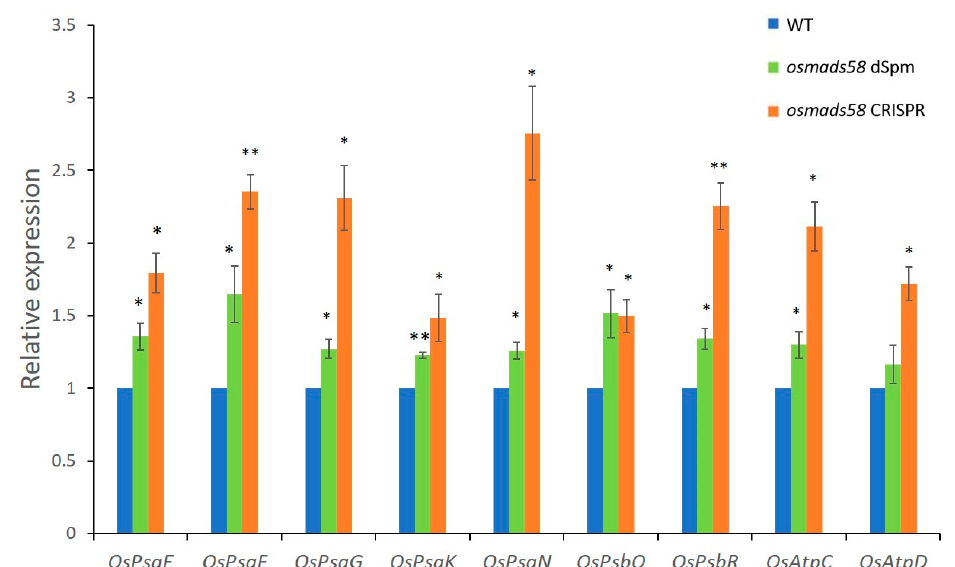
Figure 5. Expression levels verification of OsMADS58 target genes in osmads58 dSpm and osmads58 CRISPR lines. RT-qPCR analysis of expression levels of photosynthetic genes. These photosynthetic genes were upregulated in both osmads58 dSpm and osmads58 CRISPR lines, and the expression levels of these genes were much higher in osmads58 CRISPR samples. Error bars indicate SD of three biological replicates. Student’s paired t -test: * p < 0.05, ** p < 0.01.